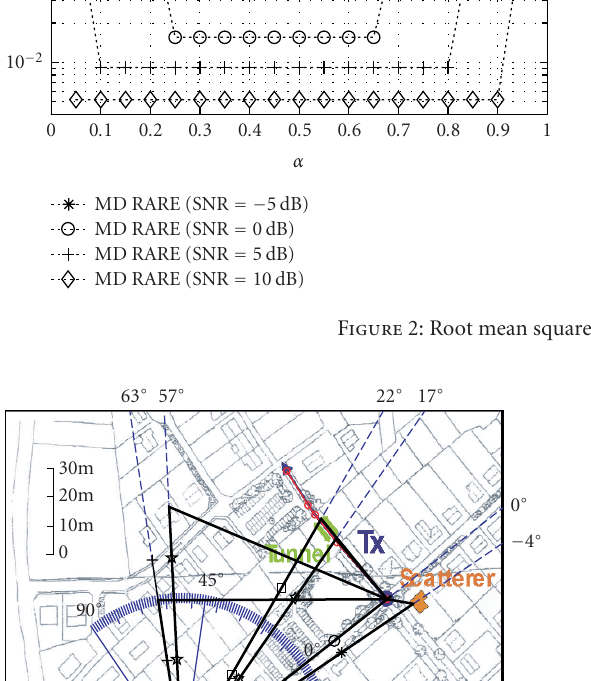
the receiver site, a uniform linear array 2 composed of 8 ele- ments with half wavelength distance (7 . 5cm) between adja- cent patch-elements was mounted on a lift in approximately 20 m